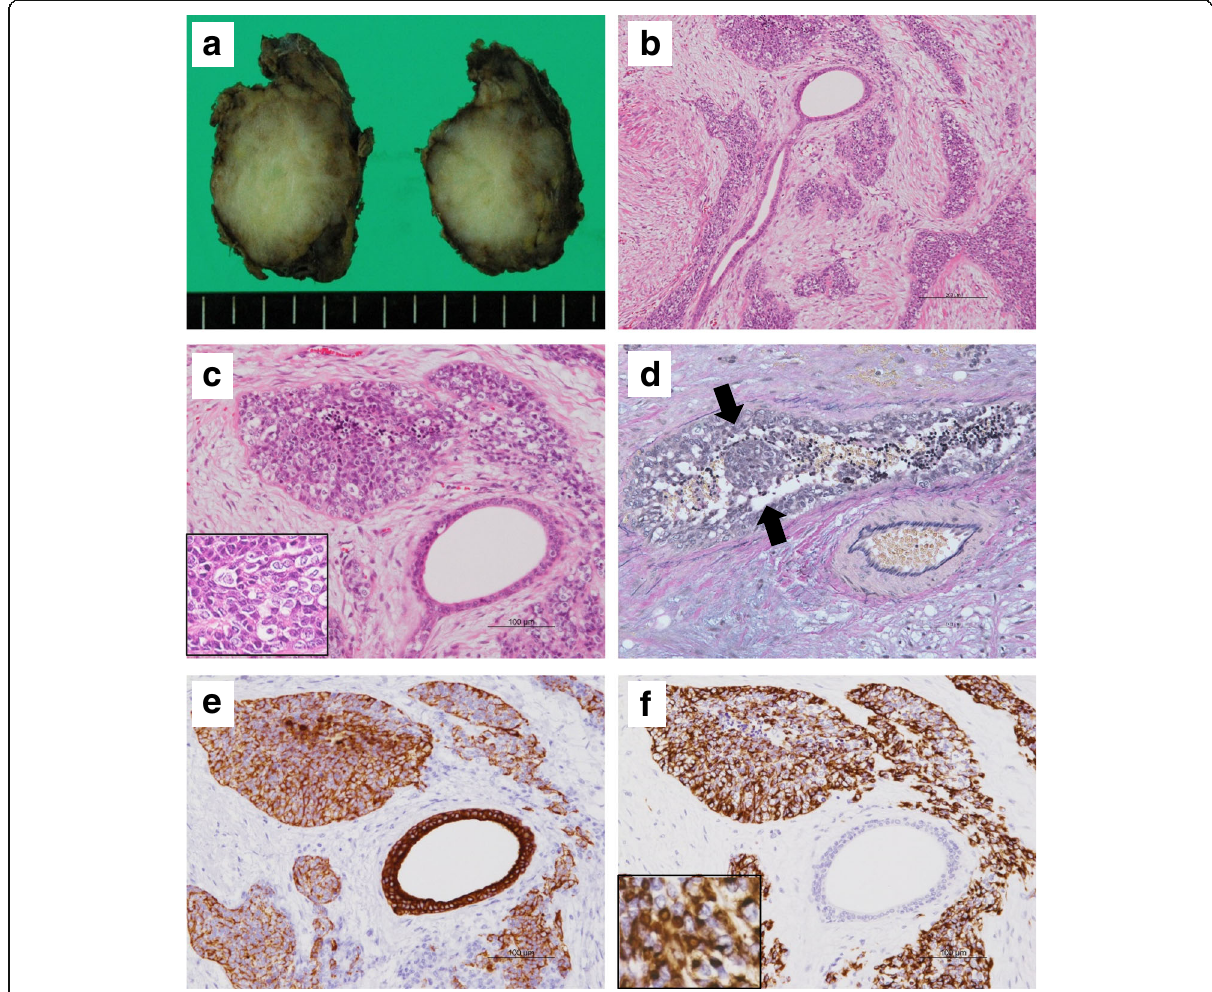
Fig. 2 Macroscopic and histological findings of the salivary gland tumor. a The resected right parotid gland mass, appearing as a firm tan-colored tumor. b Well-defined nests of tumor cells varying in size are separated by a fibromyxoid stroma. (Hematoxylin-eosin, scale bar: 200 μ m). c The nests are composed of small blue cells with scant cytoplasm and medium-sized cells with clear cytoplasm (insert). The normal salivary glands can be seen adjacent to the tumor nests. (scale bar: 100 μ m). d Venous invasion (arrows) is evident (Elastica van Gieson staining). e Immunohistochemistry of the tumor cells shows positivity for CK8/18. f The tumor cells also show diffuse cytoplasmic positivity for desmin, although focal dot-like paranuclear positivity is also seen